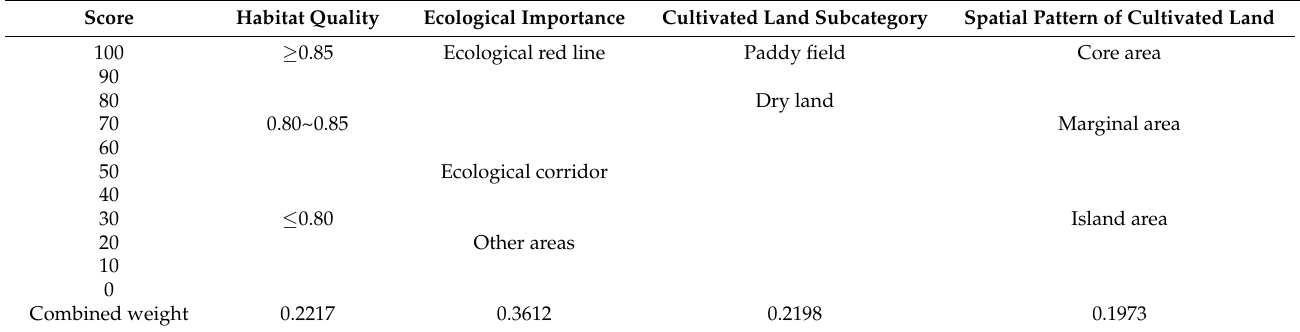
Table 6. Quantitative standard of the comprehensive evaluation index of cultivated land ecological function in Tongxiang